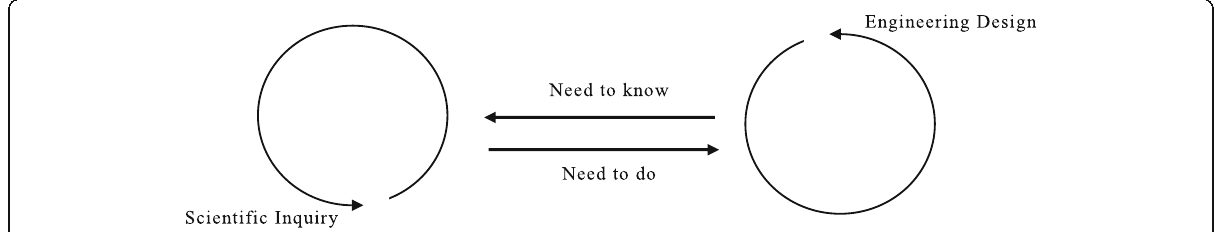
Fig. 3 The Learning by Design ™ model simplified by the authors with reference to Kolodner